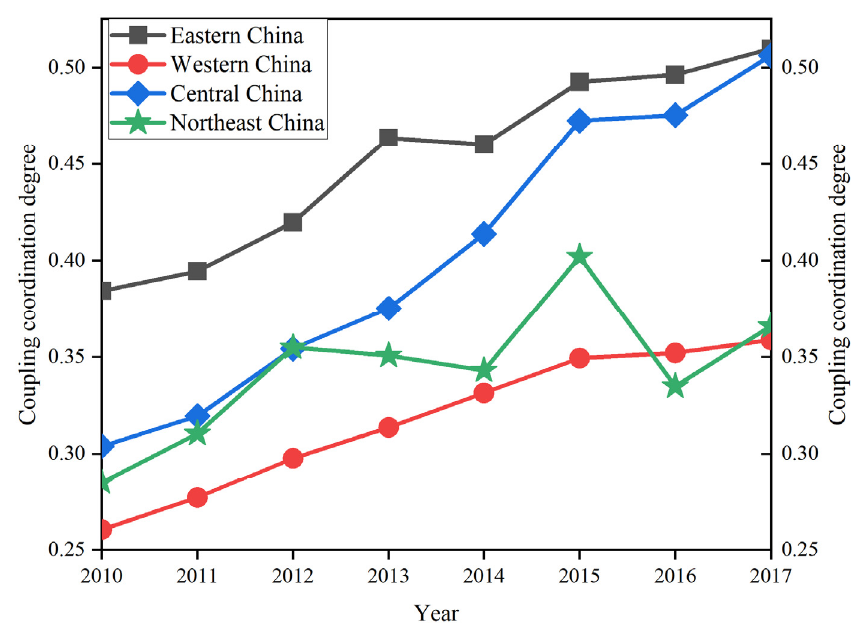
Figure 7. Temporal and spatial characteristics of the coupling coordination degree between green finance and ecosystem service demand in China from 2010 to finance and ecosystem service demand in China from 2010 to 2017.